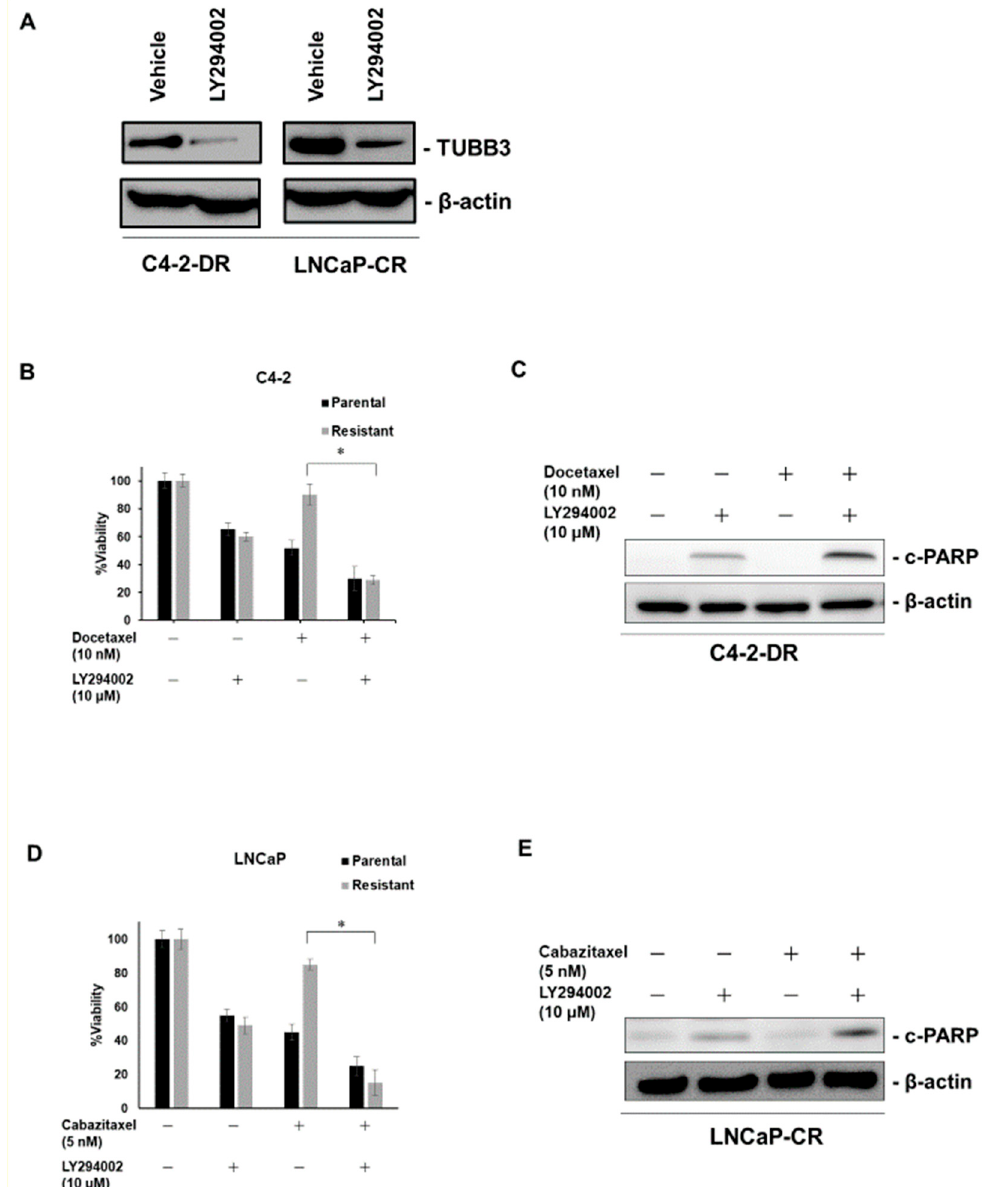
Figure 5. The effect of phosphoinositide 3-kinases (PI3K) inhibitor LY294002 on docetaxel (DTX) and cabazitaxel (CBZ) resistance. ( A ) Western blotting of TUBB3 in C4-2 DTX-resistant (C4-2-DR) cells and LNCaP CBZ-resistant (LNCaP-CR) cells treated with vehicle (ethanol) and LY294002 (20 µM). β -actin was used as a loading control. ( B ) The effect of combination therapy with DTX (10 nM) and LY294002 (10 µM) on cell viability in parental and DTX-resistant cell lines in C4-2 cells. The results are expressed as the mean and SD of triplicate measurements. * p < 0.01. ( C ) Western blotting of c-PARP in DTX-resistant cell lines in C4-2 cells treated with either LY294002 (10 nM) alone or with DTX (10 nM). β -actin was used as a loading control. c-PARP: cleaved PARP. ( D ) The effect of combination therapy with DTX (10 nM) and LY294002 (10 µM) on cell viability in parental and CBZ-resistant cell lines in LNCaP cells. The results are expressed as the mean and SD of triplicate measurements. * p < 0.01. ( E ) Western blotting of c-PARP in CBZ-resistant cell lines in LNCaP cells treated with either LY294002 (10 nM) alone or with CBZ (5 nM). β -actin was used as a loading control.